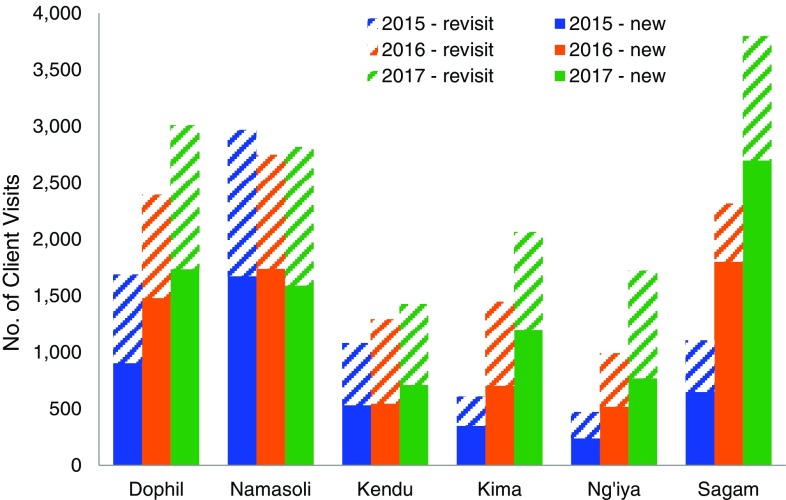
Number of Client Visits by New and Returning Visit and Facility, Kenya, Phase 2